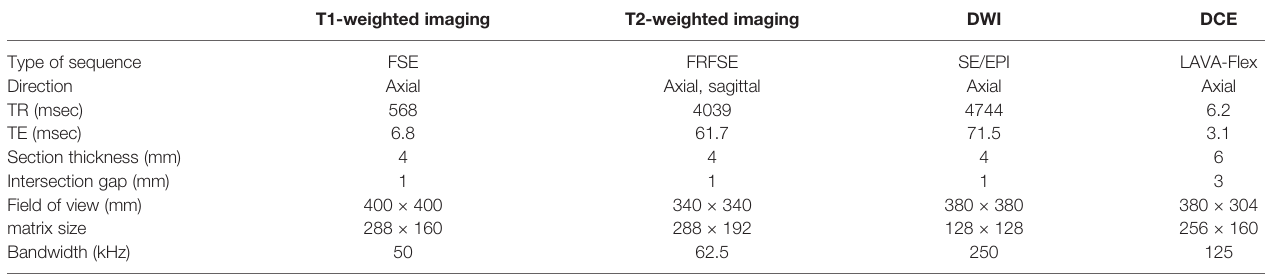
TABLE 1 | Sequence parameters of the pelvic MRI